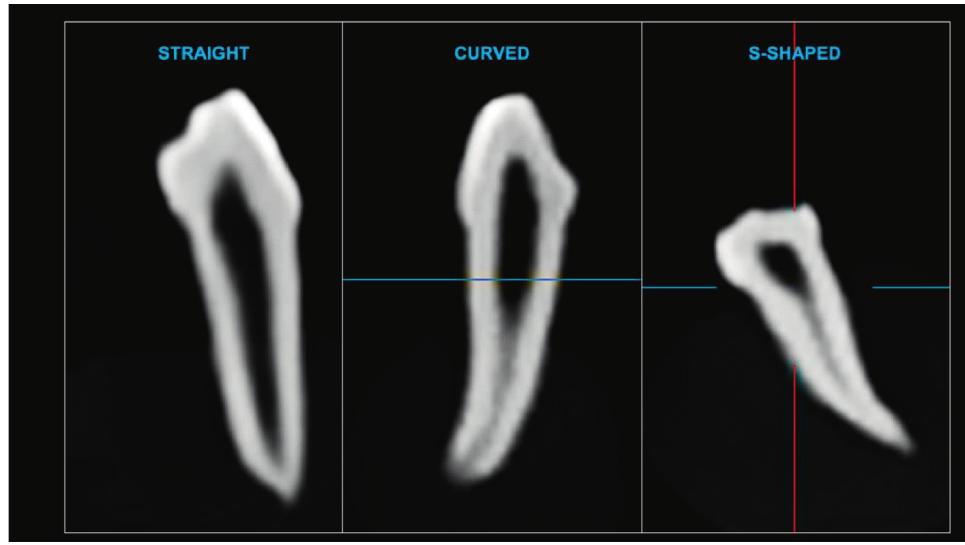
Figure 3: Shape of root canal.